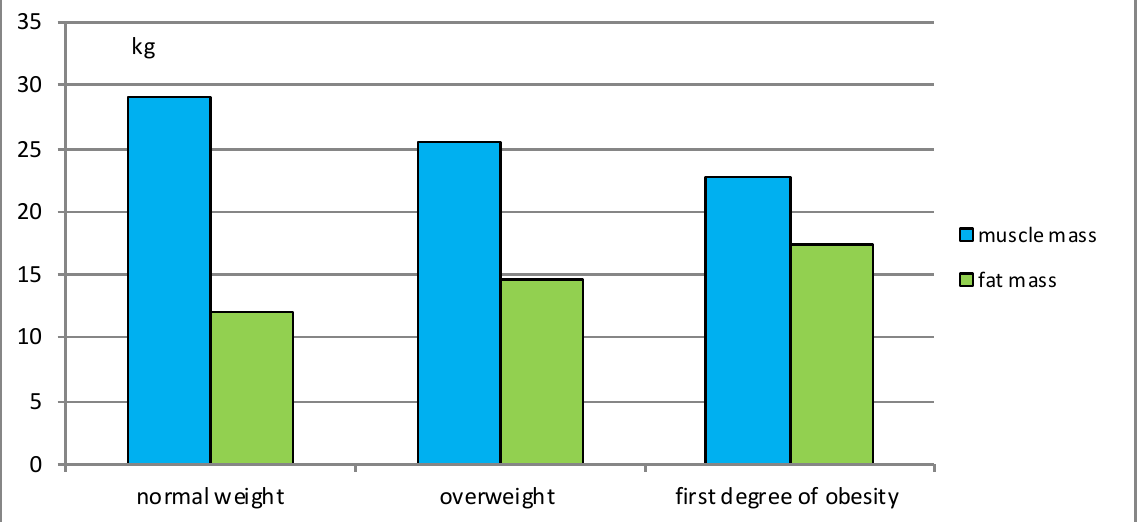
means05101520253035 normal Fig. 4. Muscular and fat structure of body (kg) of males with different BMI